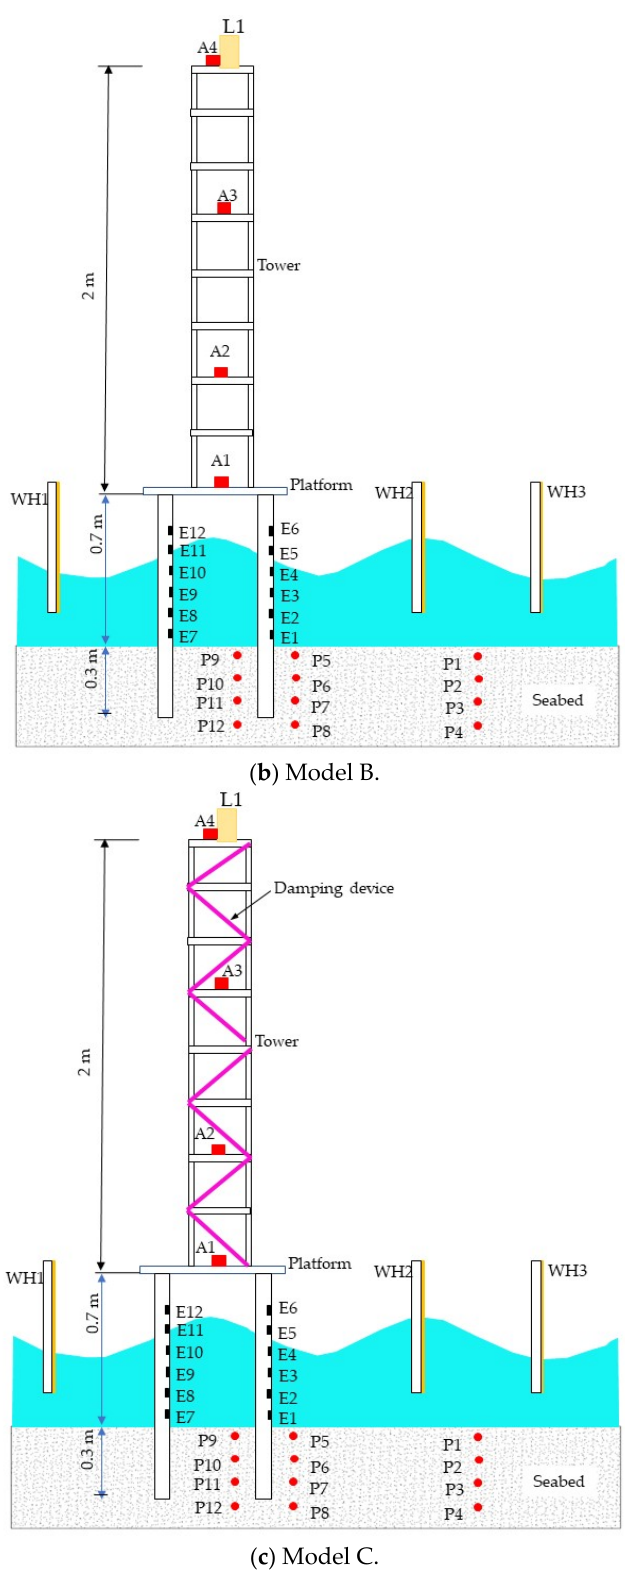
Figure 2. Sketch of the experimental setup. (A: accelerometer; E: pressure sensor; L: displacement measuring instrument; WH: wave height sensor; P: pore pressure sensor).